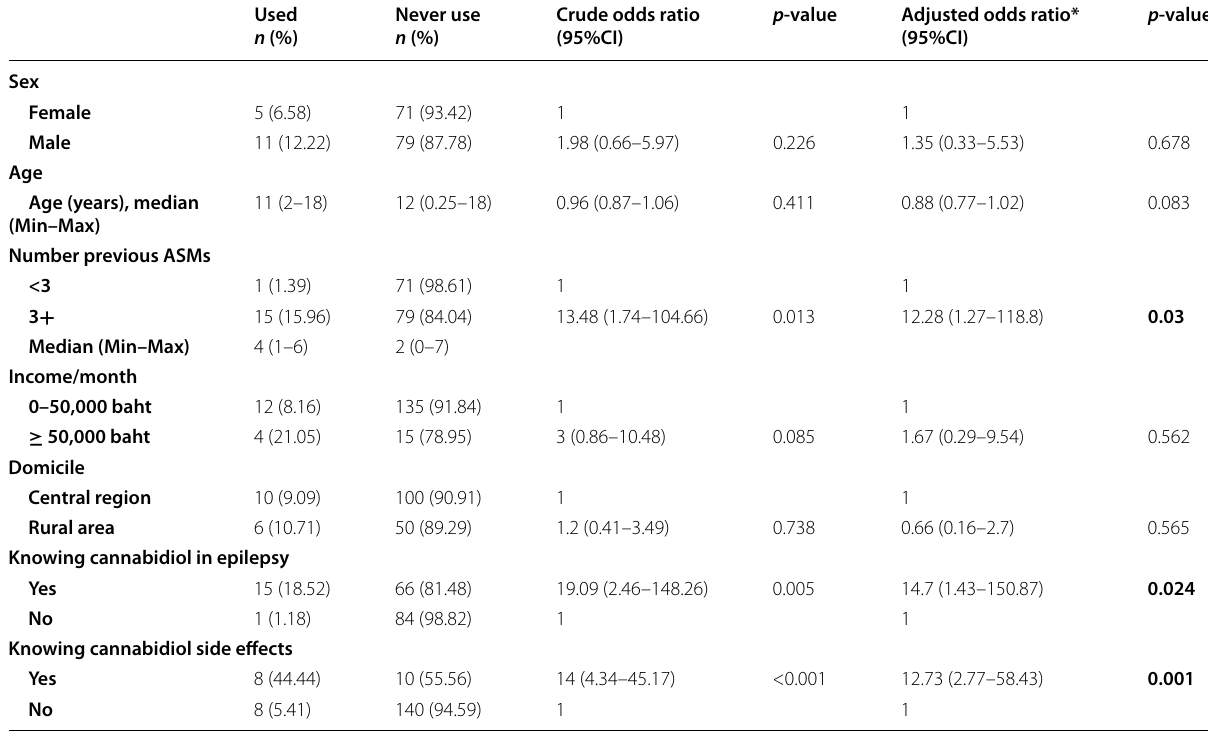
ASMs antiseizure